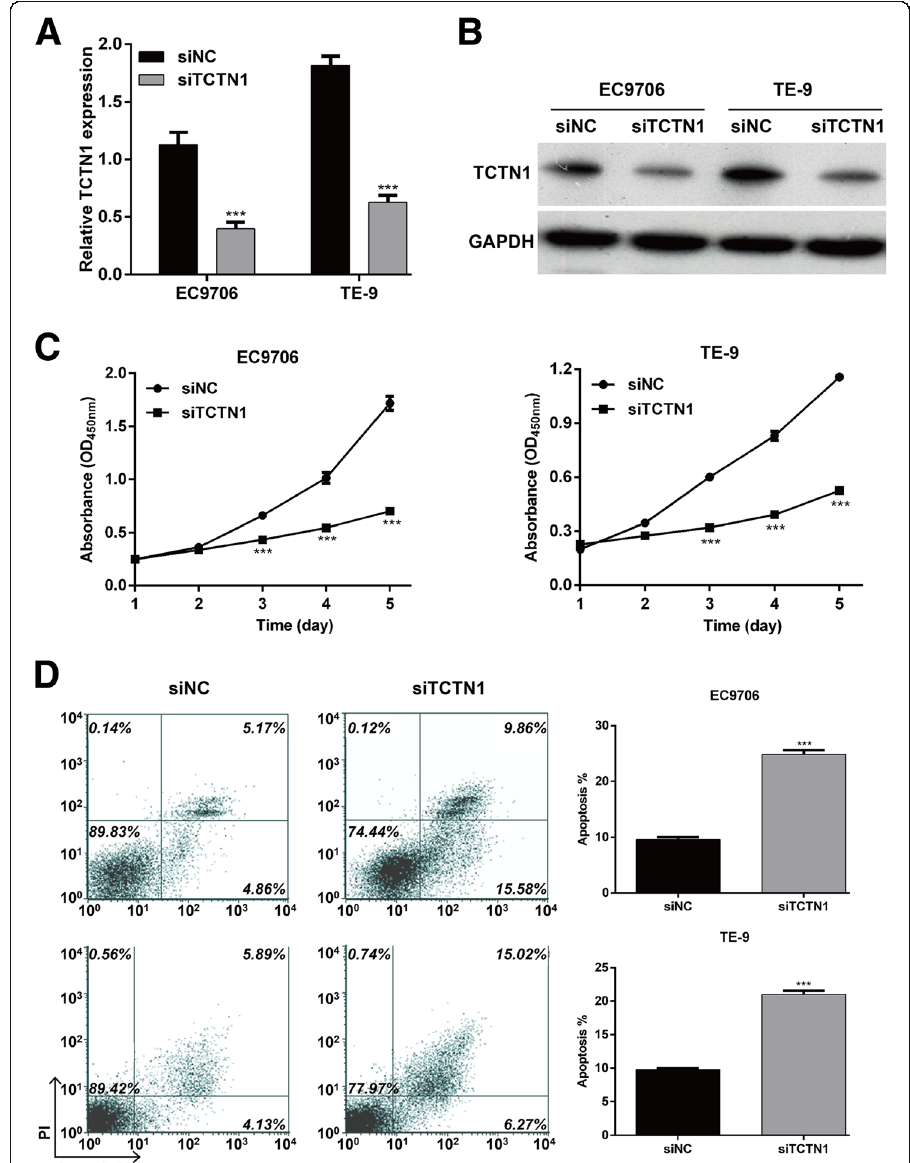
Fig. 4 TCTN1 knockdown inhibited cell proliferation and induced apoptosis in ESCC. EC9706 and TE-9 cells were transfected with siTCTN1 or siNC, respectively. a qRT-PCR and b western blot analysis were performed to measure the TCTN1 expression at mRNA and protein levels, respectively. c CCK-8 assay was used to analyze cell proliferation in EC9706 and TE-9 cells. d Flow cytometry with double Annexin V/PI staining was used to detect the ESCC cell apoptosis. *** p < 0.001 vs.